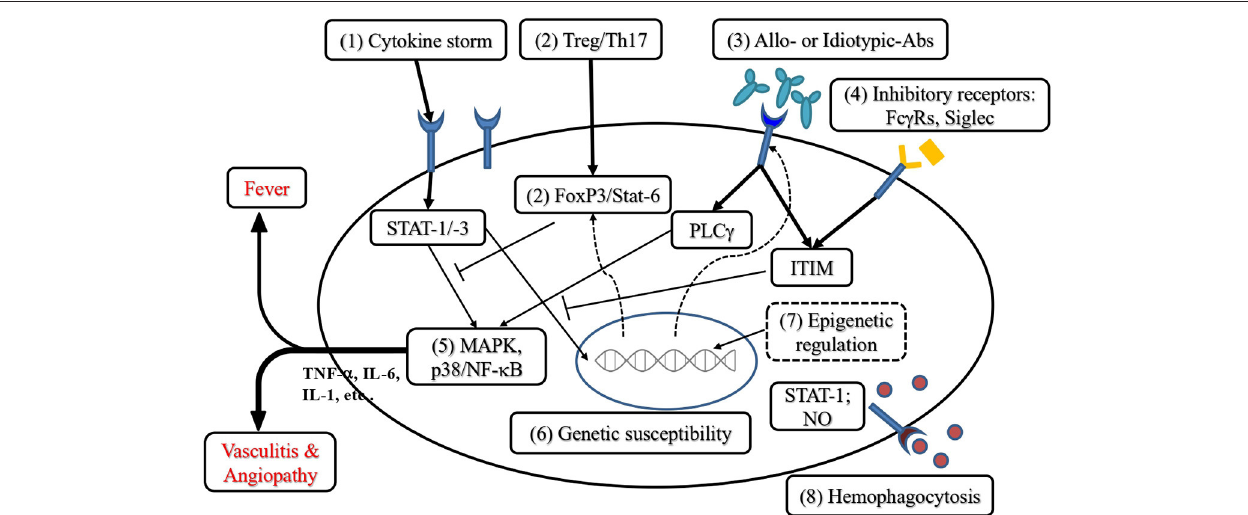
FIGURE 2 | Perspective of immunotherapies for KD refractory to conventional treatment. (1) Targeting the cytokine storm: Anti-TNF- α and anti-IL-1 have been used to rescue IVIG resistance. In addition, other Th17 and Th1 cytokines are also candidates for therapeutic targets. (2) Addressing the Th17/Treg imbalance can be achieved by augmentation of Th2 or Treg polarization, including the enhancement of FoxP3 expression. (3) Blockade or immunoregulation by allotypic and idiotypic IgG provides immunoregulation of KD. (4) Enhancement of immunoinhibitory receptors transduces the immunoreceptor tyrosine-based inhibitory motif (ITIM) to inhibit cytokine production. (5) Targeting the signal transduction of mitogen-activated protein kinases (MAPK) including p38 phosphorylation to suppress cytokine (TNF- α , IL-6, IL-1, etc.) production. (6) Screening genetic variants related to KD with IVIG resistance protects KD patients from coronary complications. (7) Epigenetic regulation of Treg immune responses reverses the Th17/Treg imbalance in KD with IVIG resistance. (8) Anti-hemophagocytosis can be achieved by targeting IFN- γ and TNF- α as well as the inhibition of their downstream effector STAT-1 (signal transducer and activator of transcription 1) or nitric oxide (NO) synthase activation ( → indicates activation; ⊥ indicates inhibitory regulation; - - - > indicates epigenetic regulation).